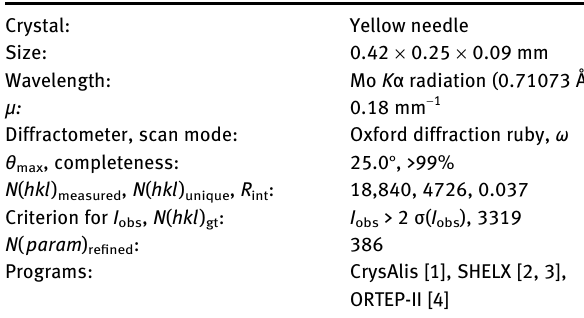
Table  : Data collection and